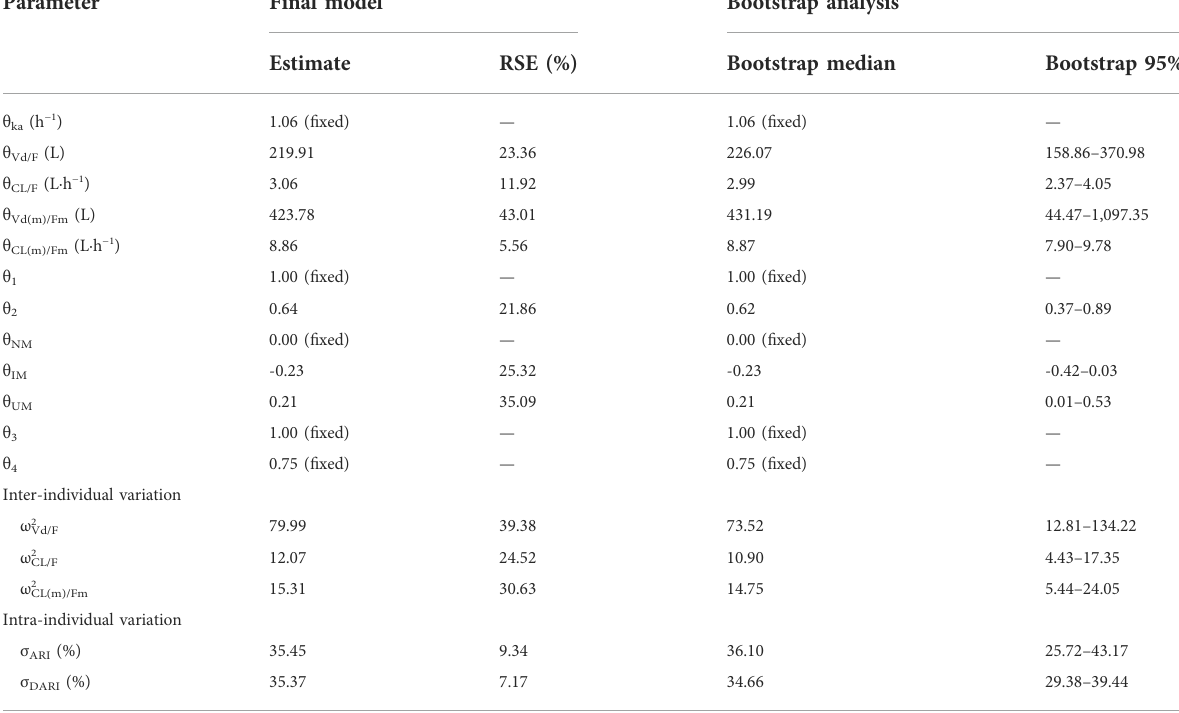
TABLE 3 Pharmacokinetic parameters and bootstap results of the fi nal